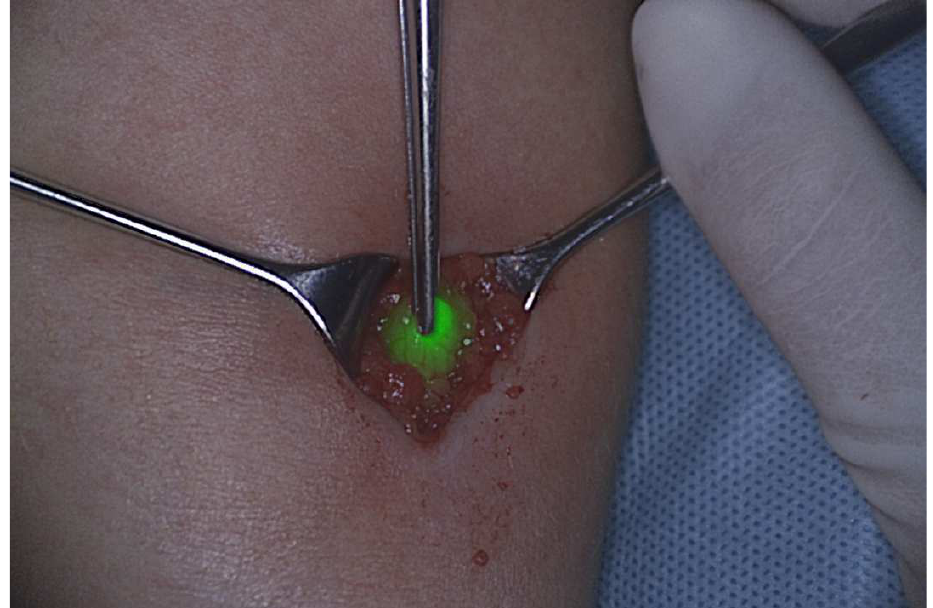
Figure 2. Sentinel node detected by near-infrared light.